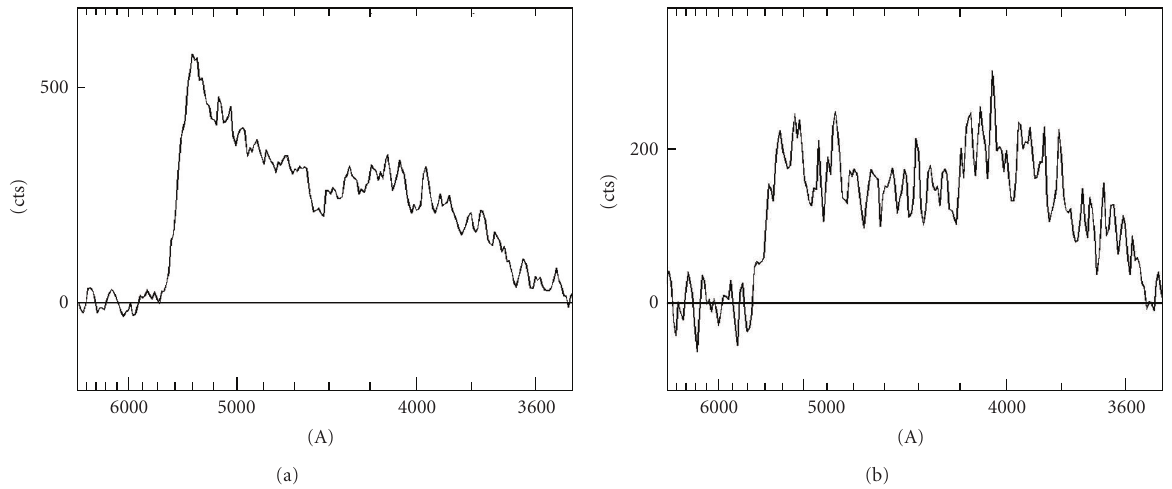
Figure 8: Example spectra of cataclysmic variable (a) and blazar (b) (digitized Hamburg